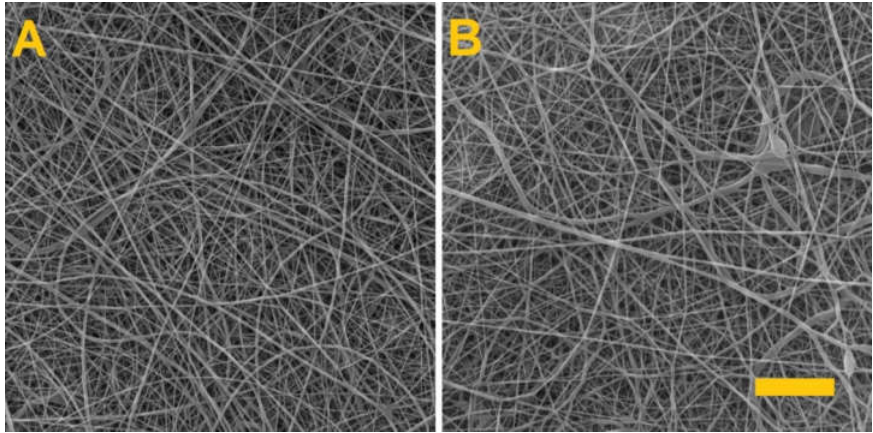
Figure 4. The PVA fiber layer. ( A ) Prior to crosslinking. ( B ) After 4 h of exposure to the glutaraldehyde vapor. Scale 10 μm.